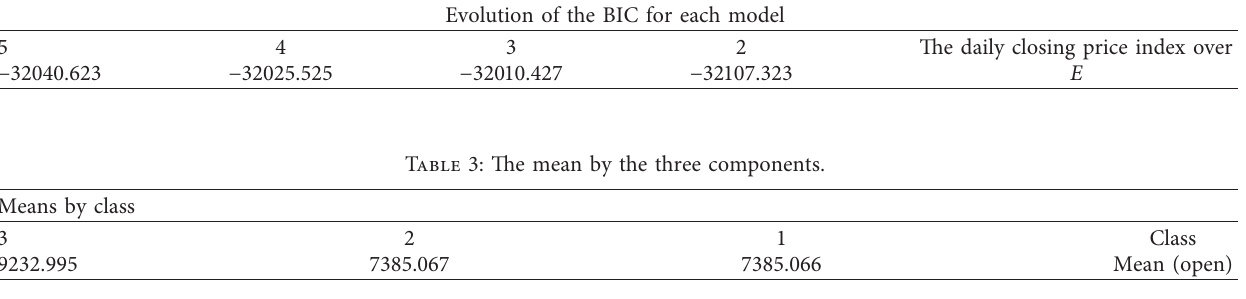
Table 2: Selection criterion is Bayesian information criterion. Evolution of the BIC for each model